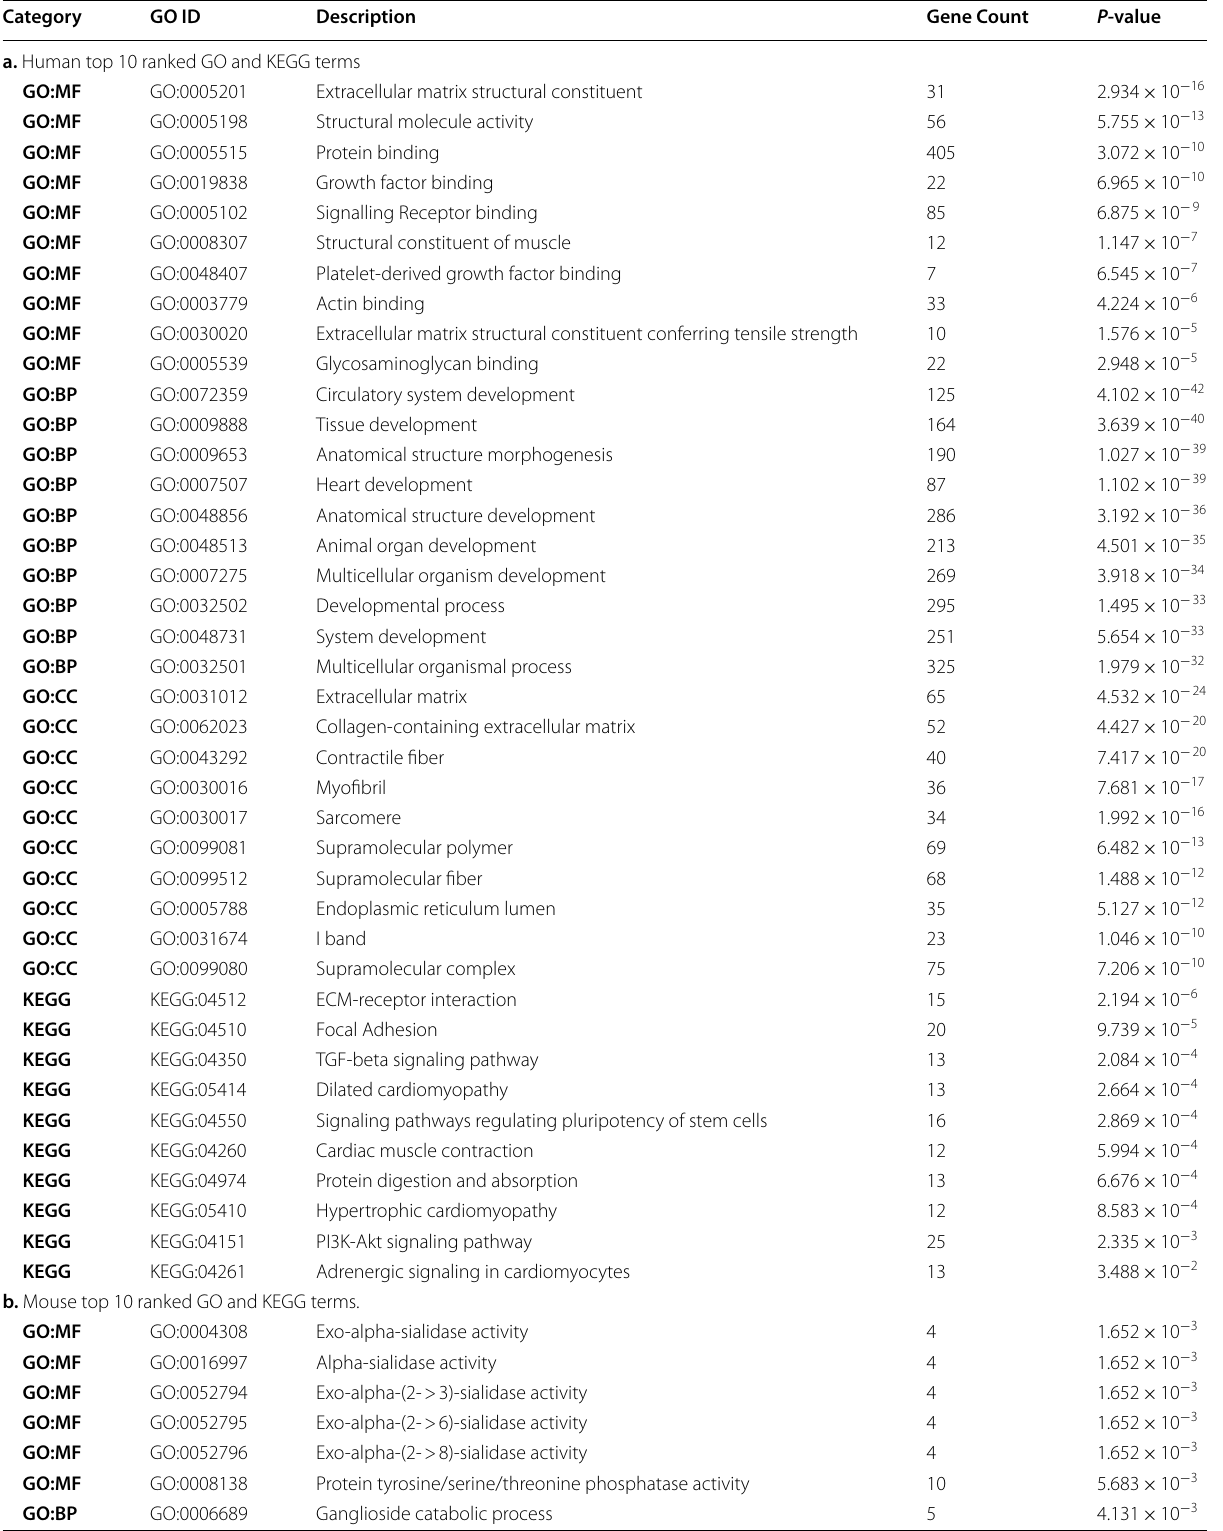
Table 1 Top 10 ranked GO and KEGG terms for DEGs for a) human or b) mouse data sets Category Description Gene Count P